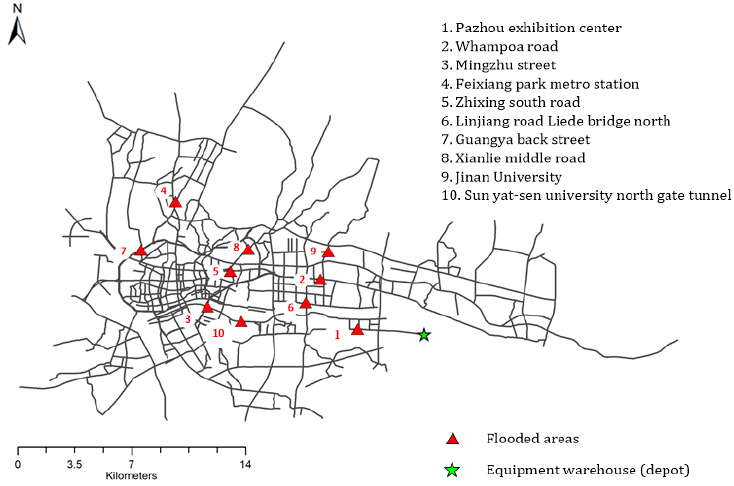
Figure 5. Experimental area, including the locations of 10 flooded areas and the equipment warehouse.